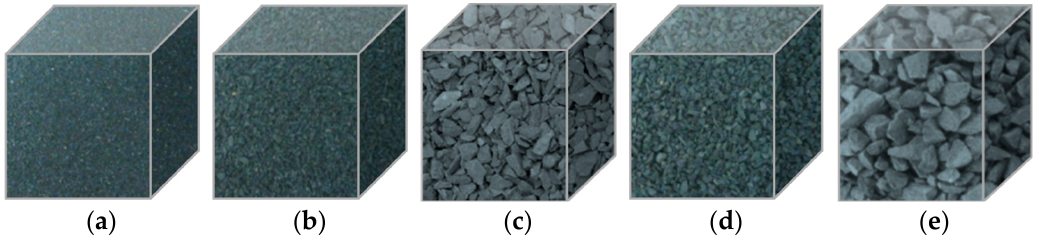
Figure 5. Quartzite sand: ( a ) #0.15 mm; ( b ) #0.30 mm; ( c ) #0.60 mm; ( d ) #1.20 mm; and ( e ) #2.40 mm.